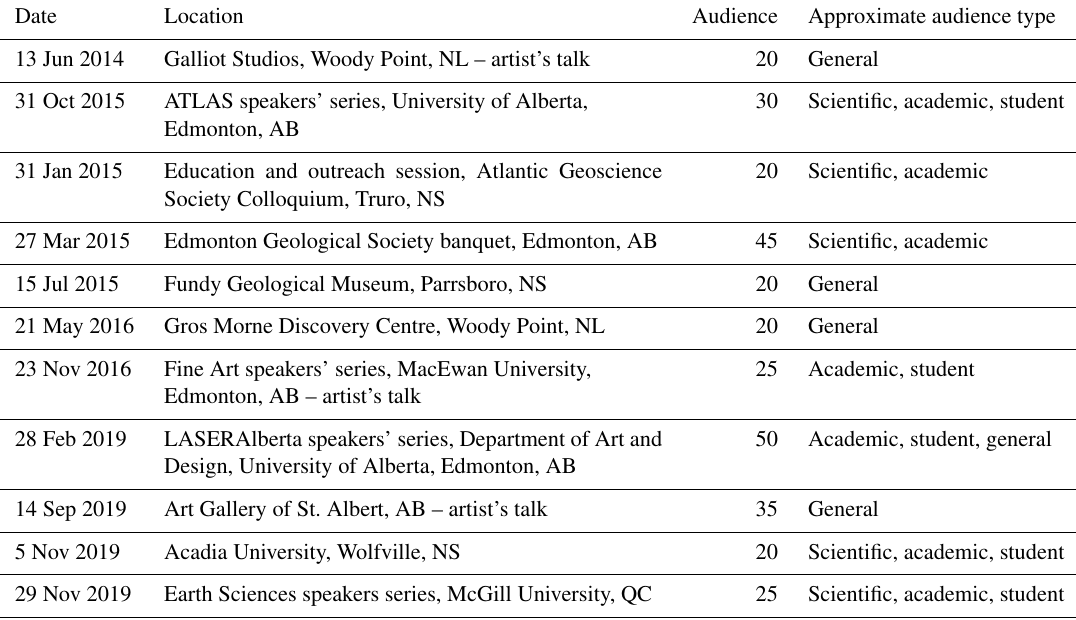
Table 1. Presentations by date and location. Note: NL – Newfoundland; AB – Alberta; NS – Nova Scotia; QC –